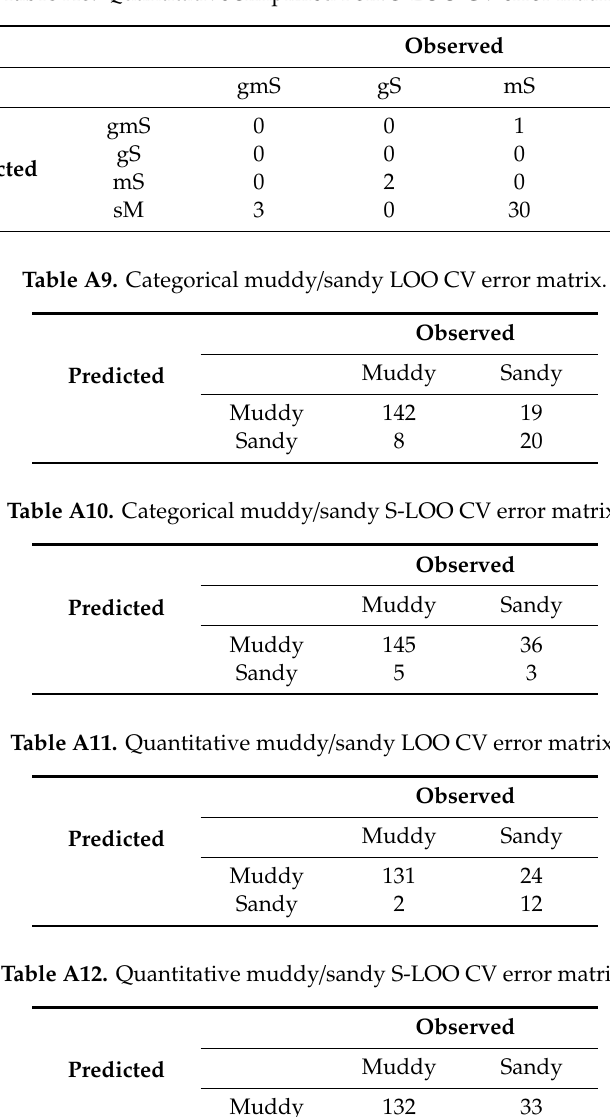
Table A8. Quantitative simplified Folk S-LOO CV error matrix.